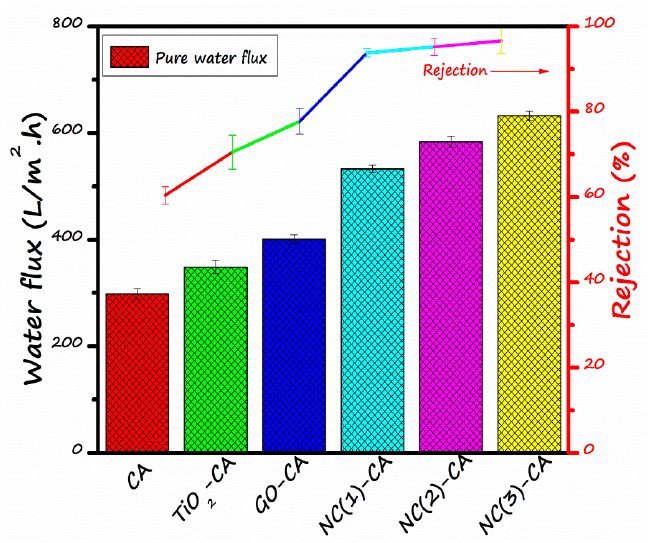
Figure 10. Pure water flux ( left y -axis) and rejection ( right y -axis) of several membranes. Figure 10 illustrates the MO rejection and pure water flux (PWF) of various